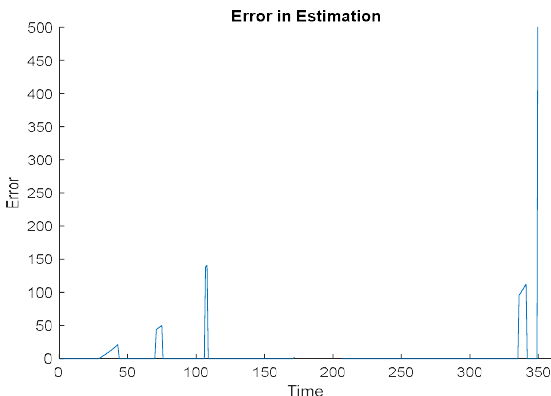
Figure 9. Object localization error in EEODTF for trajectory 1. 4.2.5. Network Lifetime Analysis For any object detection and tracking application, the lifetime of the network is very important. The following figures (Figures 10–12) compare the lifetime of the network of the proposed framework, the EEODTF, with the EETLO model and PSOEETTM in terms of the number of alive nodes, the number of dead nodes and the residual energy of the network at the end of the simulation (433 rounds). From the figures, it is clear that the proposed framework is more energy efficient in comparison to the other two models; see Figures 10 and 11. A total of 254 nodes were deployed. For the EEODTF, this was the optimal number of nodes required to cover the AOI. This number of nodes remained the same in the other two models to compare their performance. There were more alive nodes at the end of 433 rounds in the EEODTF than in the other models.